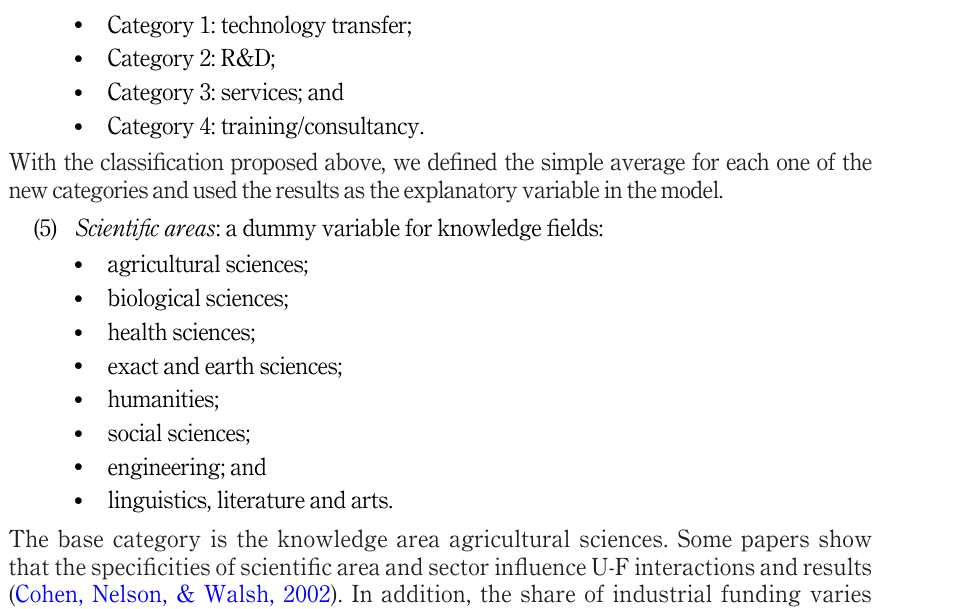
Table IV. Modes of